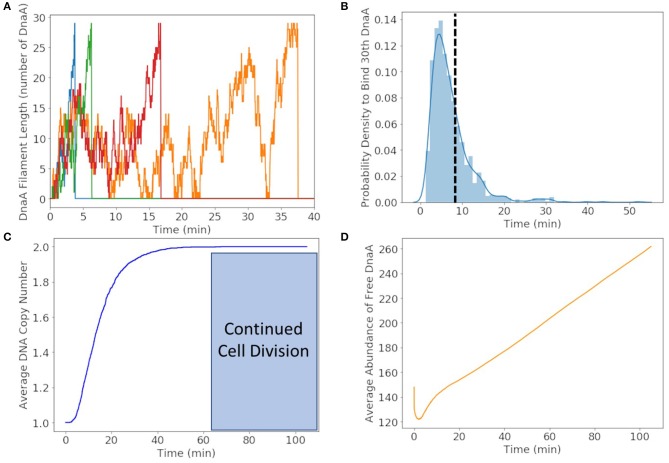
(A) DnaA filament formation for four different replicates shown in different colors. The stochastic effects of the filamentation kinetics result in a wide range of times to form the filament from <5 to 50 min. (B) Probability distribution of replication initiation times when the thirtieth DnaA in the ssDNA filament binds. We predict the most probable time to form the filament to be approximately 5 min and the average time to be approximately 8 min shown with a dotted line. (C) Average of genome duplication over 1,000 replicates shows that on average the genome will be duplicated in 65 min of the 105 min cell cycle, leaving approximately 40 min for continued cell division. (D) The average abundance of DnaA not bound to DNA gets depleted by filament formation and replenished by translation and removal of the filament by DNA helicase.